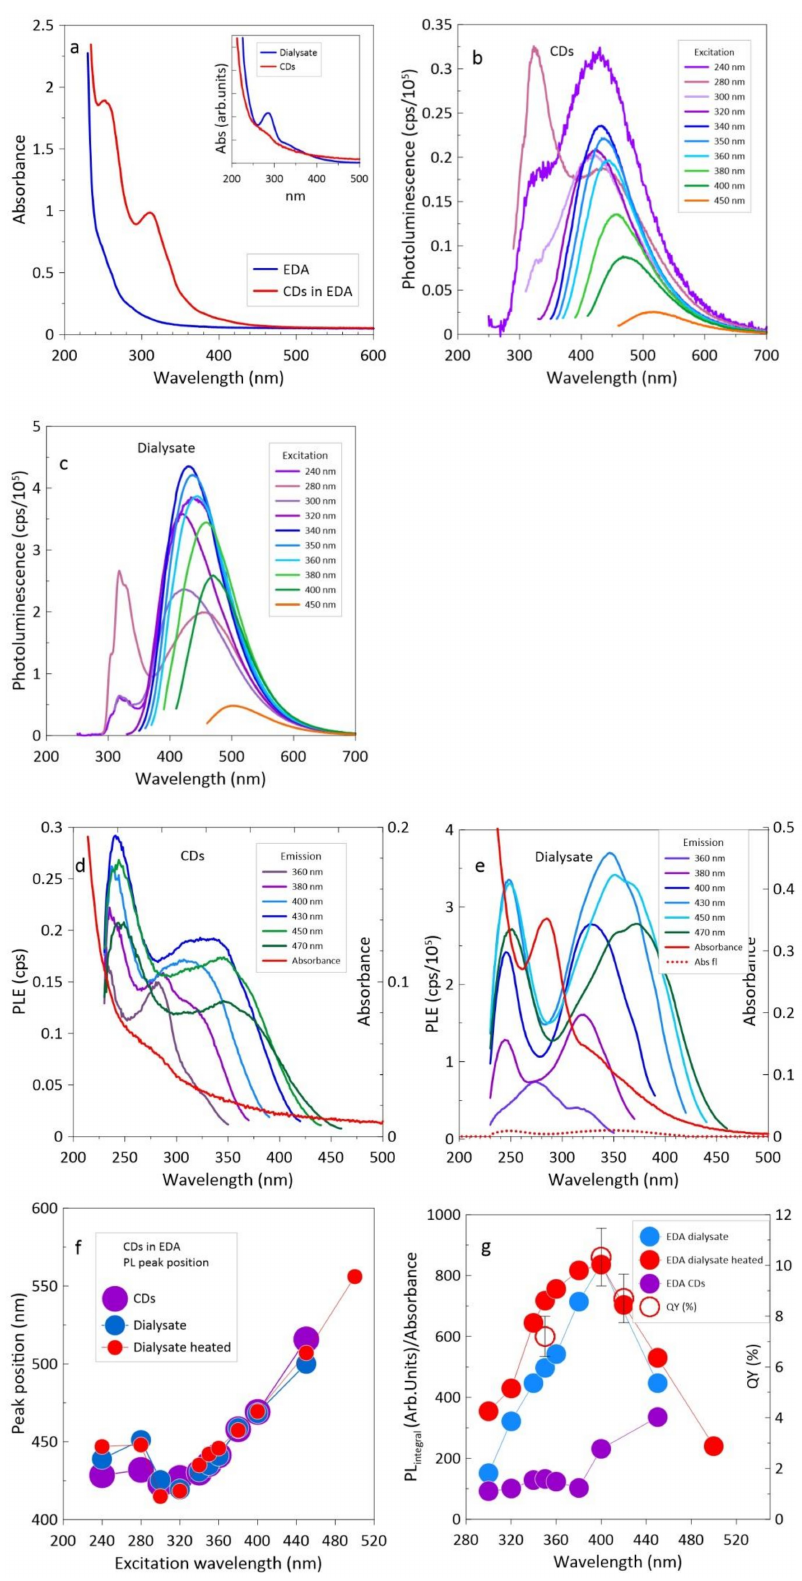
Figure 6. Optical properties of dialyzed CDs and dialysate: ( a ) absorbance; ( b ) PL of CDs; ( c ) PL of dialysate; ( d ) PL excitations scans of CDs; ( e ) PLE of dialysate; ( f ) PL peak position; and ( g ) ratio of integrated photoluminescence to absorbance